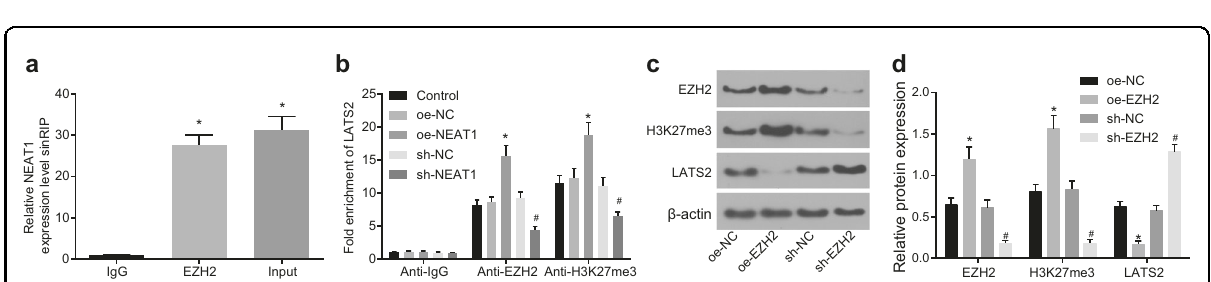
Fig. 4 Downregulation of lncRNA NEAT1 or overexpression of LATS2 inhibits the progression of FHF in vivo. The protein expression patterns of YAP1 in the nucleus/cytoplasm of rat liver determined by western blot analysis ( a , b ). Immunohistochemical staining of Ki67 expression in the livers of FHF rats (×400) ( c , d ). Apoptosis in the livers of FHF rats observed by TUNEL staining (×400) ( e , f ). The pathological changes in the livers of FHF rats detected by HE staining (×400) ( g ). * p < 0.05 vs. the FHF + oe-NC group; # p < 0.05 vs. the FHF + sh-NC group. FHF group, FHF rats induced by D-GalN/ LPS injection; FHF + oe-NC group, FHF rats treated with oe-NC; FHF + oe-LATS2 group, FHF rats treated with oe-LATS2; FHF + sh-NC group, FHF rats treated with sh-NC; FHF + sh-NEAT1 group, FHF rats treated with sh-NEAT1. Statistical data are described as mean ± standard deviation. One-way analysis of variance was used for comparisons among multiple groups, followed by Tukey ’ s post hoc test. n = 6 in each group. D-GalN/LPS D- galactosamine/lipopolysaccharide, lncRNA NEAT1 long noncoding RNA nuclear-enriched abundant transcript 1, LATS2 large tumor-suppressor kinase 2, FHF fulminant hepatic failure, TUNEL terminal deoxynucleotidyl transferase (TdT)-mediated 2 ′ -deoxyuridine 5 ′ -triphosphate (dUTP) biotin nick end labeling, HE hematoxylin – eosin.